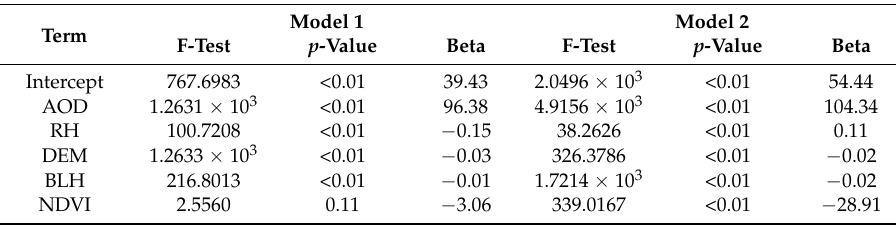
Table 4. Analysis of variance (F-test and p -value) explained by each of the individual terms in different models. Beta is the coefficient of the fixed term for the two models.